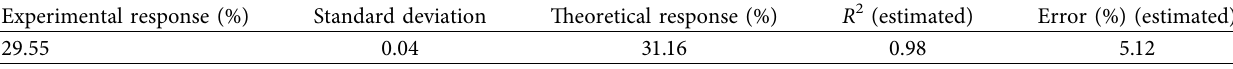
Table 8: Experimental response for culture conditions’